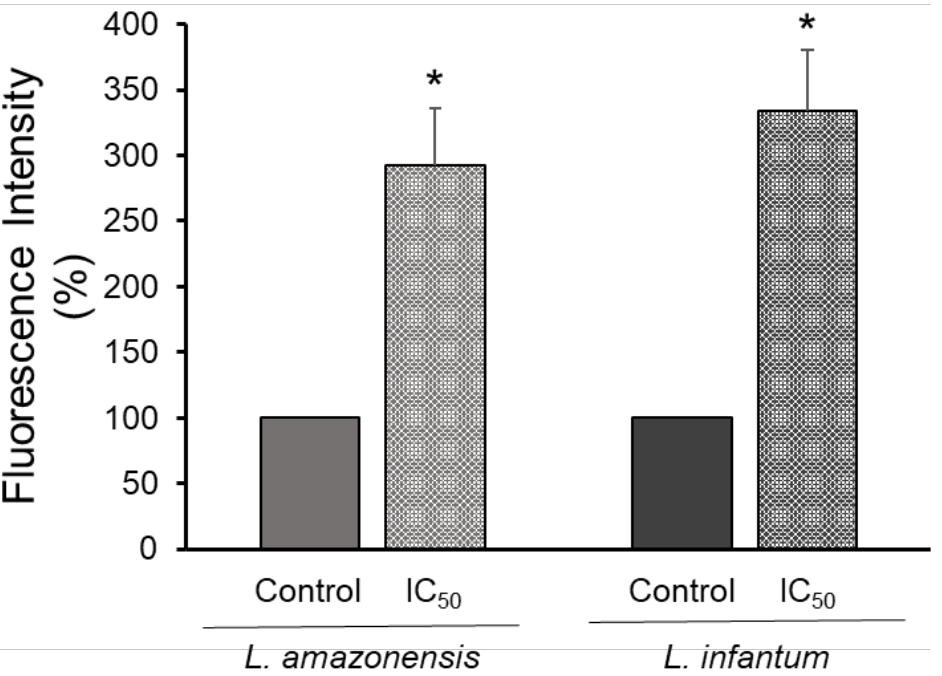
Figure 3. Effect of tryptanthrin on the autophagic activity of Leishmania spp. Promastigote forms of L. amazonensis and L. infantum were treated with IC 50 values (11 and 8.0 µM, respectively) of tryptanthrin. The results are presented as the mean percentage relative to the control. Statistical analysis of the differences between mean values obtained for the experimental groups was done by Student’s t -test. The asterisks indicate significant differences (* p < 0.05) in the autophagic activity between treated parasites and their respective controls (100% activity).